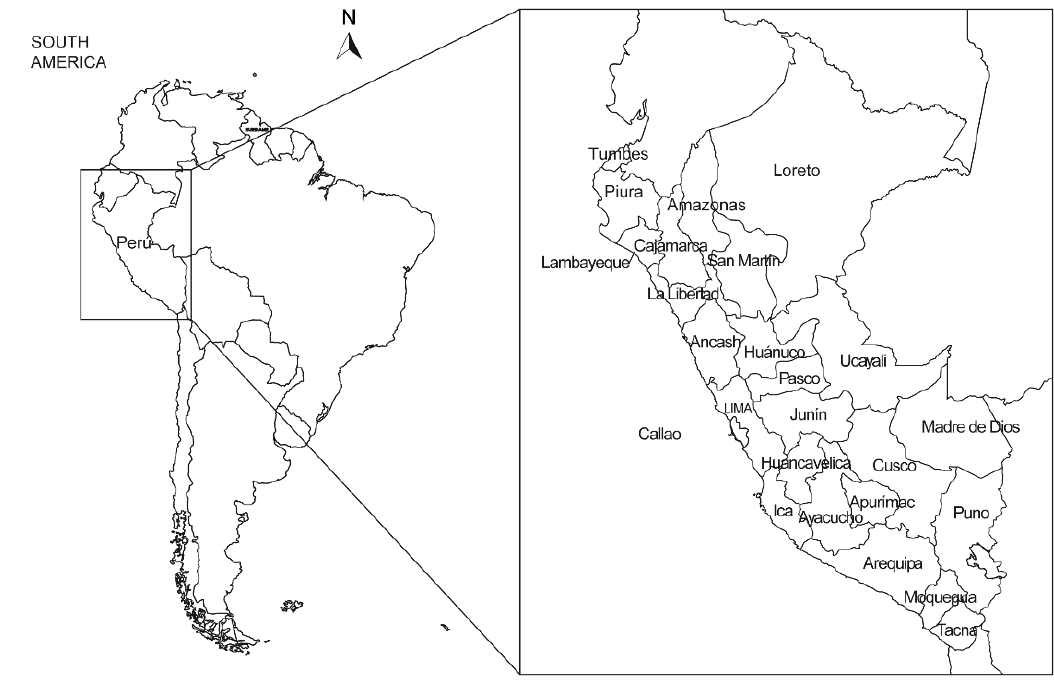
Figure 1. Location of Peru within South American.